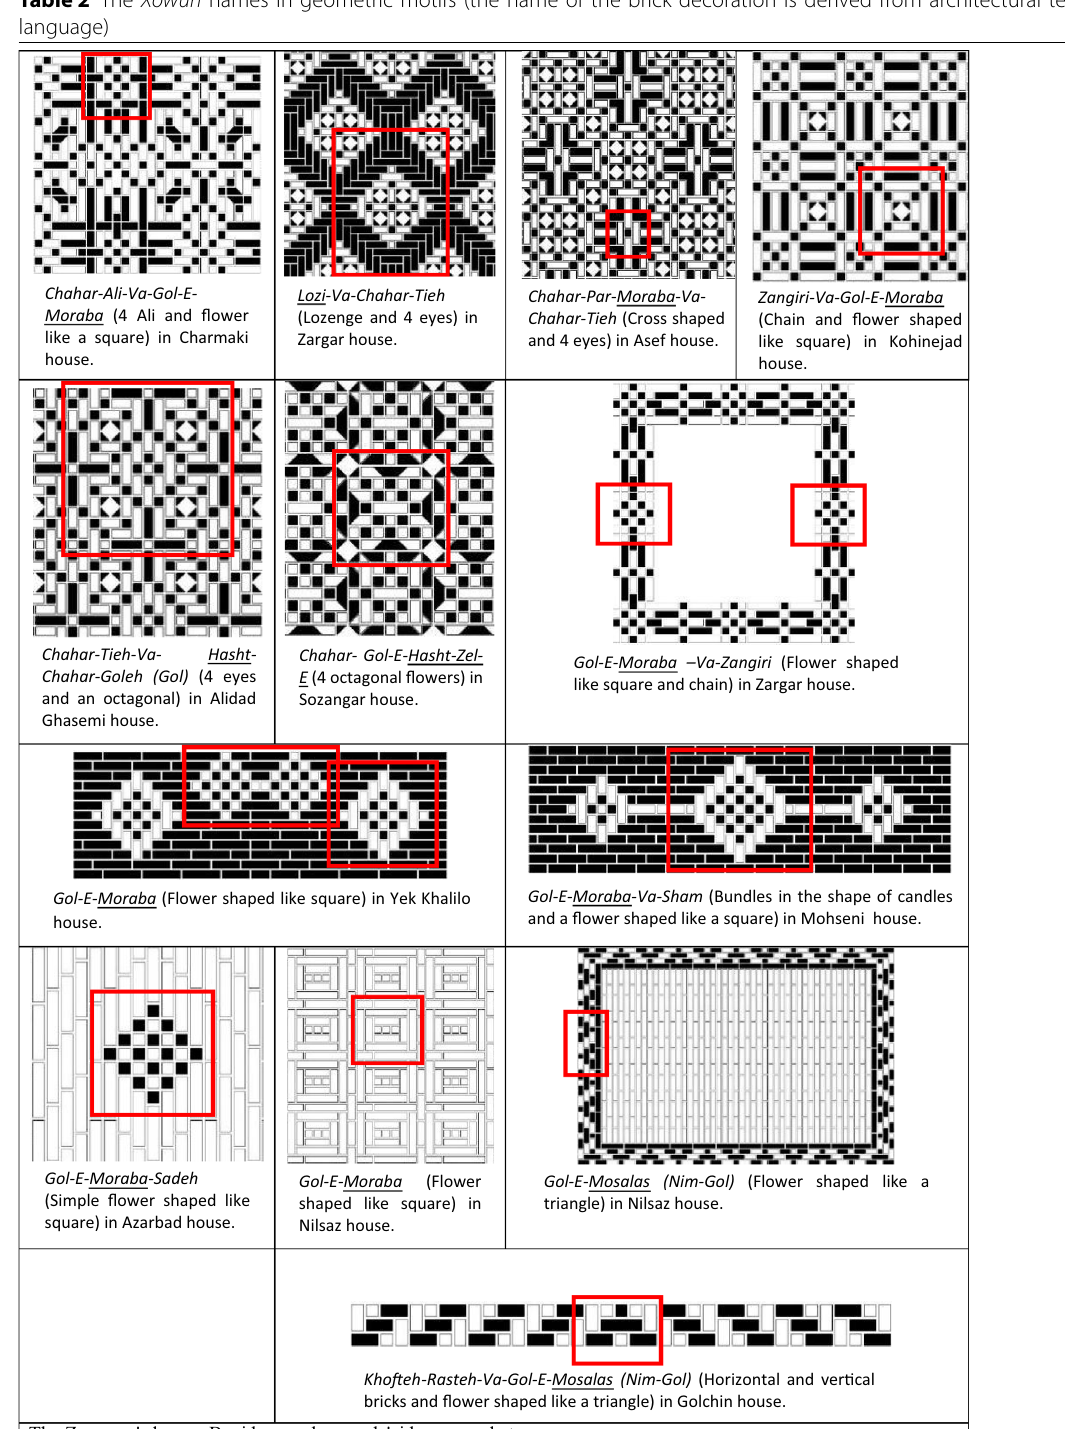
Table 2 The Xowun names in geometric motifs (the name of the brick decoration is derived from architectural terms in the native